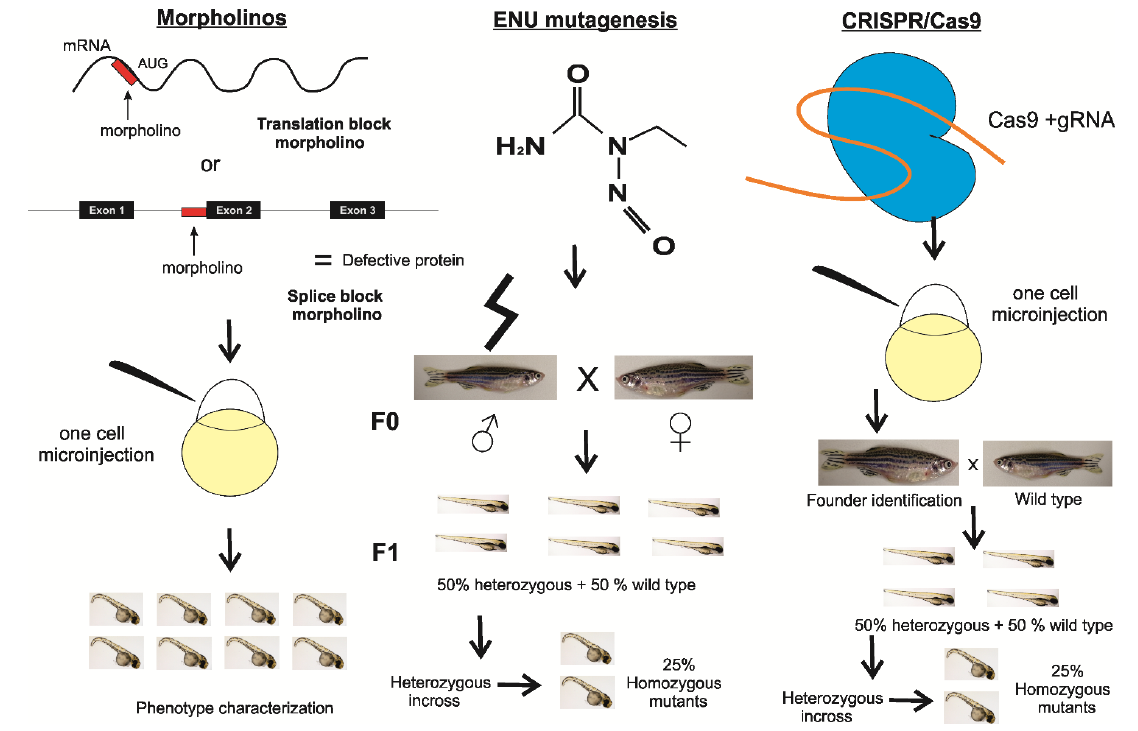
Figure 1. Main techniques for generating zebrafish loss of function models. Table 1. Summary of molecular mechanisms and main clinical features of the ataxias discussed in this article.